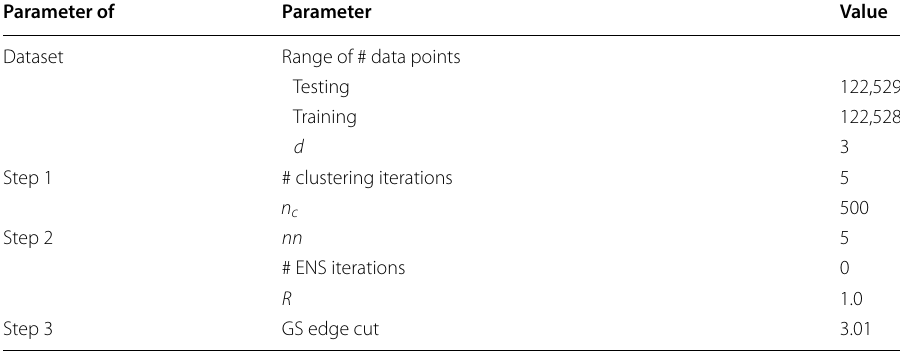
Table 7 Dataset IV, and test 1 and 2 parameters Parameter of Dataset